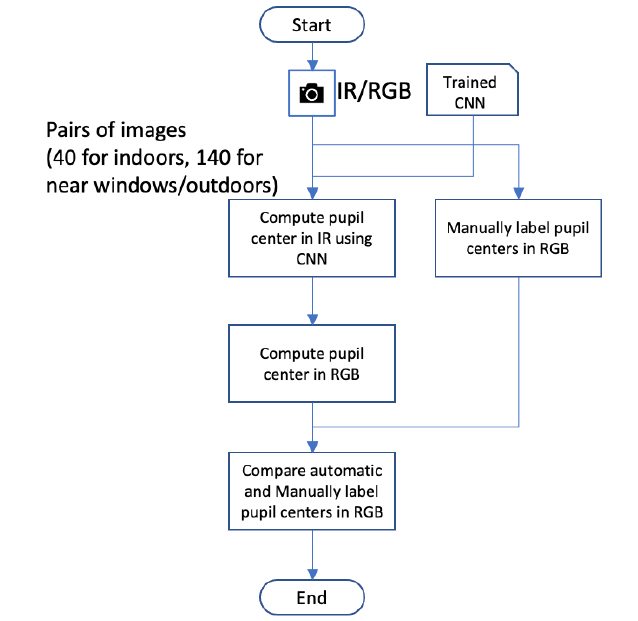
Figure 9. The flowchart describing the procedure of the framework’s